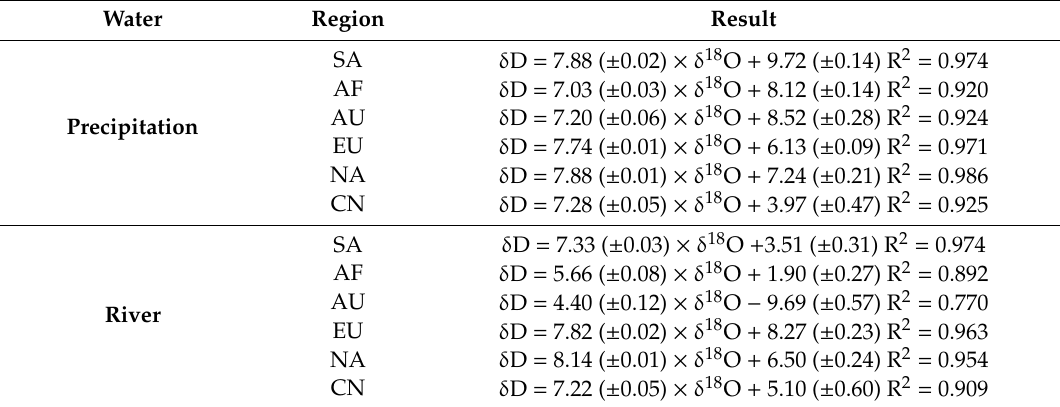
Table 2. Relationship between δ 18 O and δ 2 H in precipitation and rivers in six regions. SA, AF, AU, EU, NA, CN represent South America, Africa, Australia, Europe, North America and China,